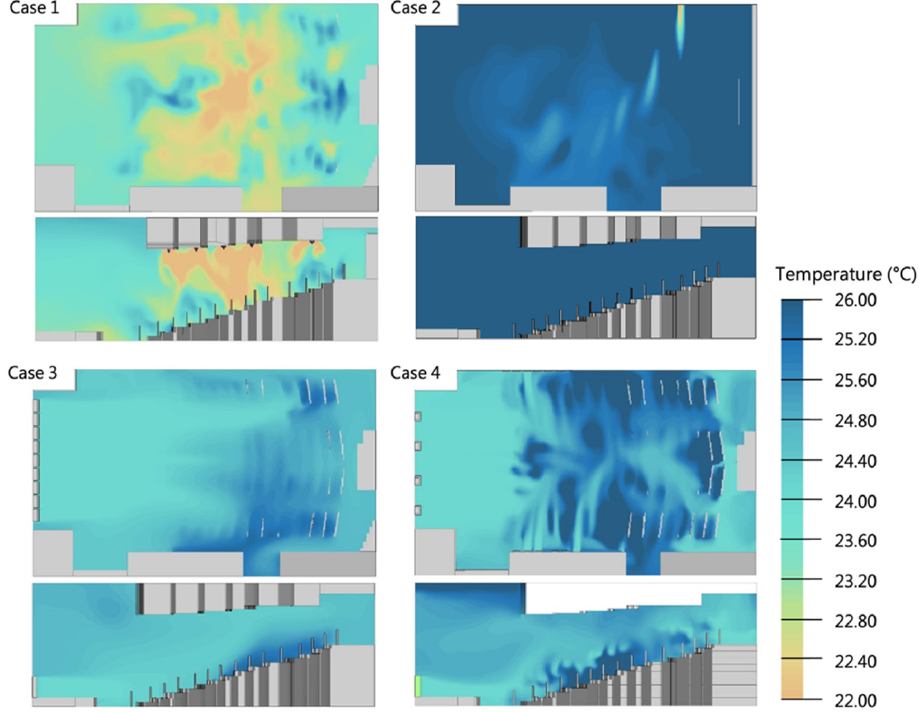
Figure 16. Temperature distribution of each case.